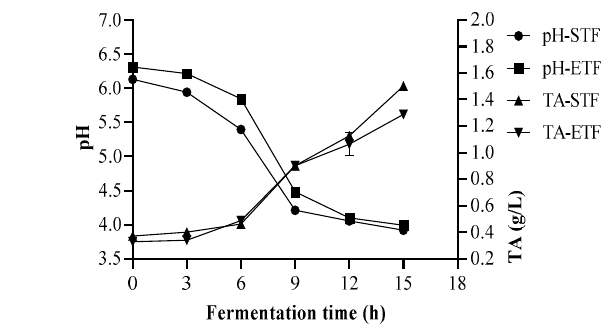
Table 7. DMFit estimated kinetic parameters of growth, pH, and TA during the mixed-strain fermentation of ETF and STF substrates.